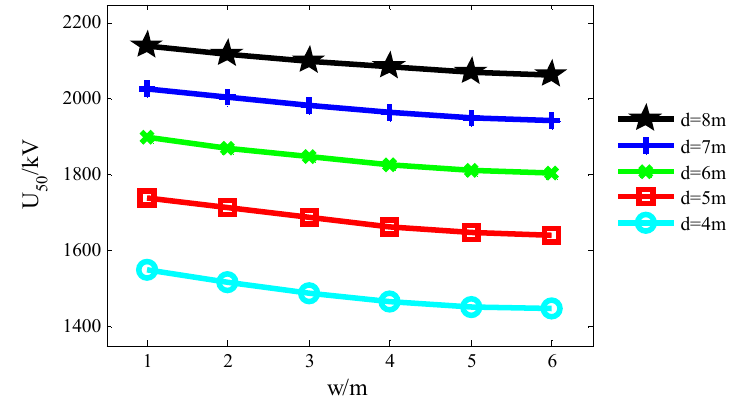
Figure 4. U 50 of conductor-tower gaps with different heights.